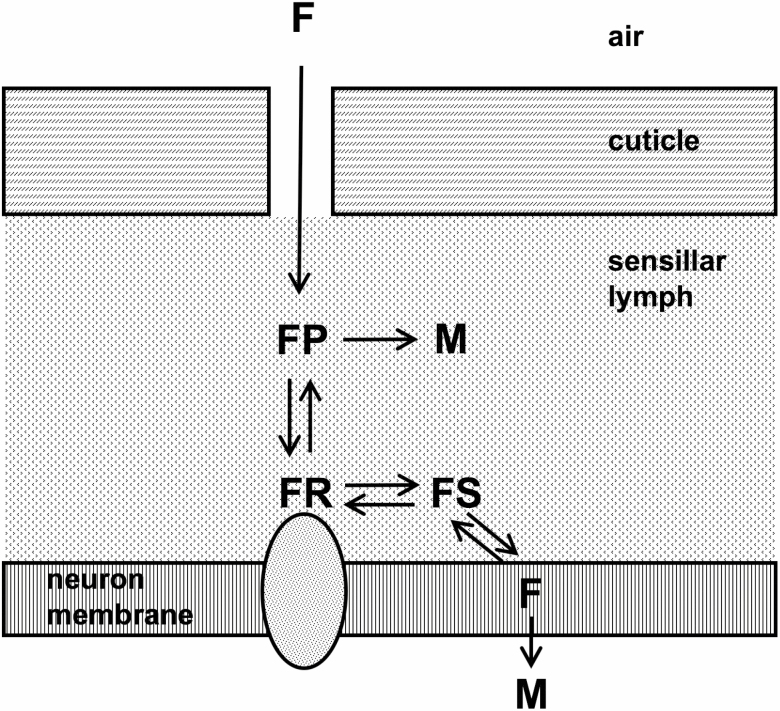
Model for pheromone deactivation. Modified from Kaissling (Kaissling 2009, 2013). Upper rectangles: cuticle, showing pore leading from air to antennal lymph. Lower rectangle: lipid bilayer of olfactory receptor neuron membrane with olfactory receptor shown as embedded oval. F: pheromone or odorant; FP: pheromone or odorant bound to odorant-binding protein or other transport protein; M: metabolite of pheromone or odorant after deactivation; FR: pheromone or odorant bound to extracellular domain of olfactory receptor; FS: complex between pheromone or odorant and SNMP1 or other receptor-to-membrane transporter. Deactivation enzymes catalyzing the FP to M and F to M steps are not shown.